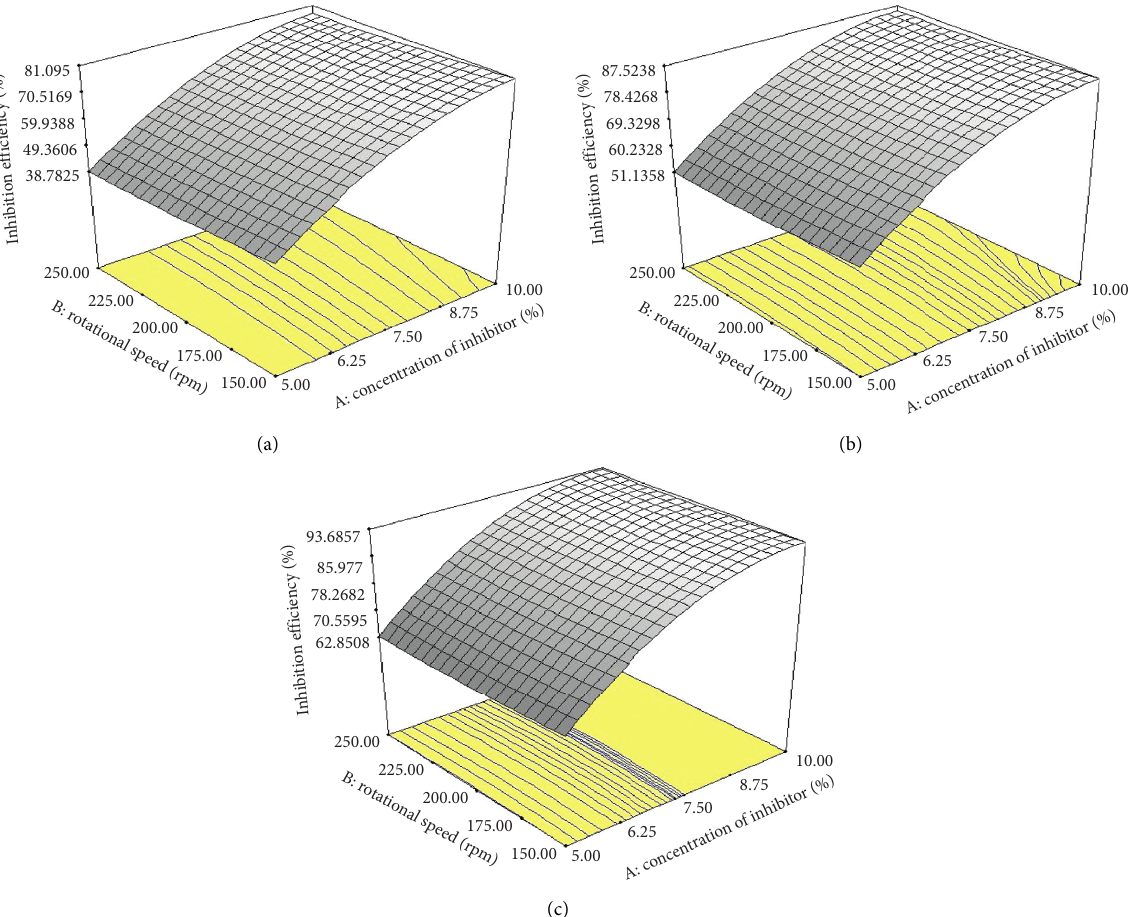
Figure 17: 3D plot of inhibition efficiency as a function of inhibitor concentration and rotation speed at temperatures (a) 75 ° C, (b) 50 ° C, and (c) 25 °